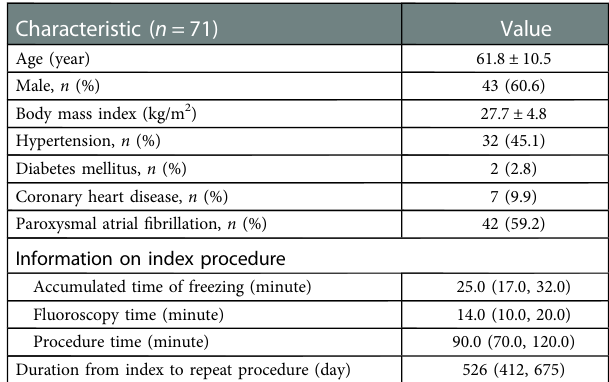
TABLE 1 Baseline characteristics of the patients and index cryoablation